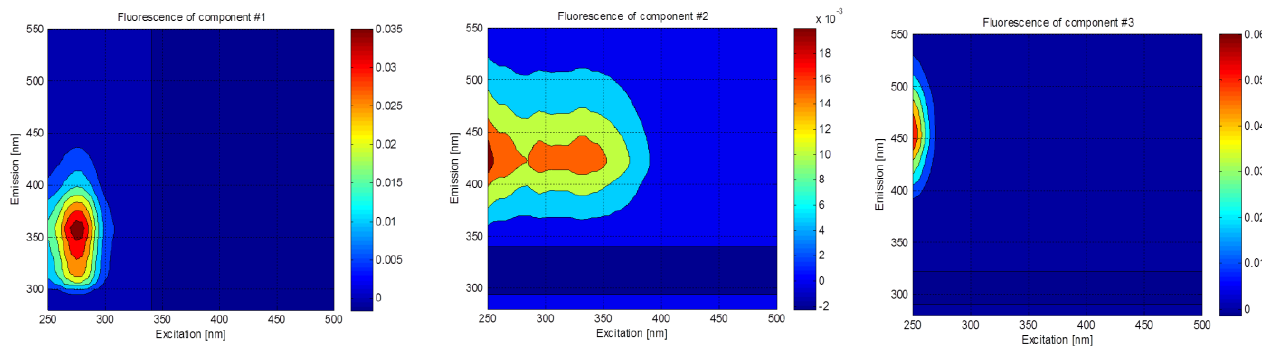
Figure 2. EEM contours of fluorescent components identified using